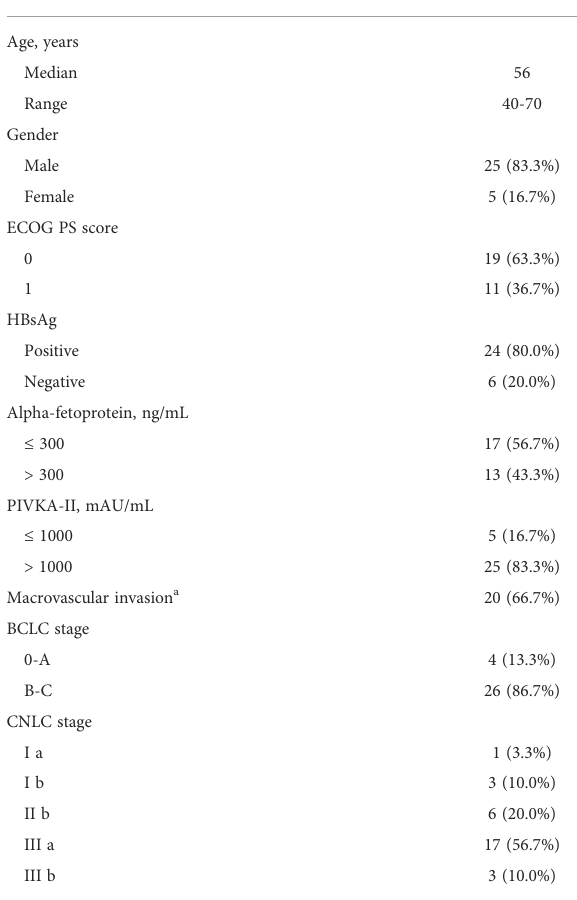
TABLE 1 Baseline demographic and clinical characteristics of HCC patients receiving surgery after treatment with lenvatinib plus anti- PD-1 antibody (n =